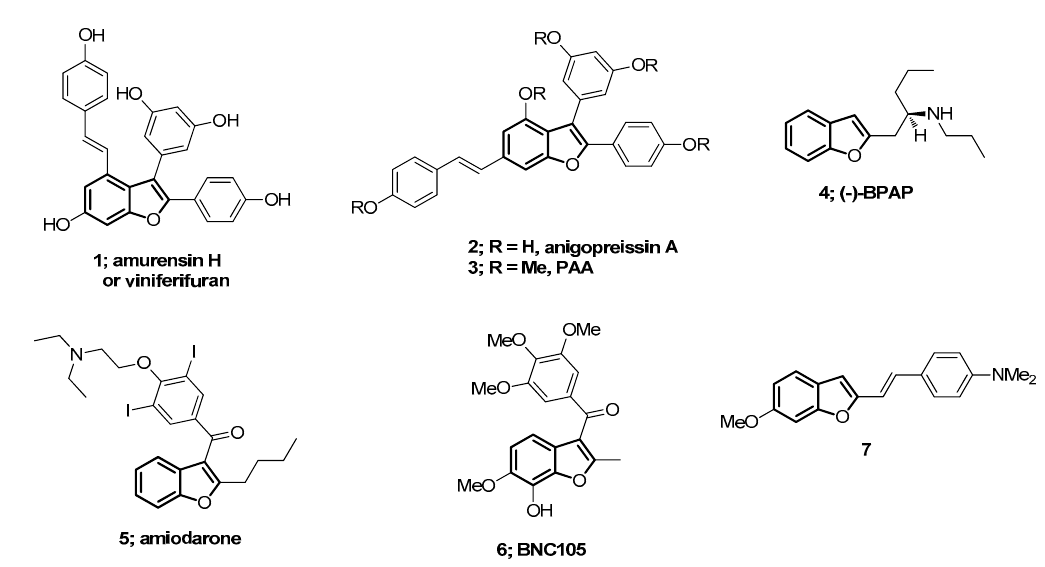
Figure 2. Representative pharmacologically active BF derivatives.